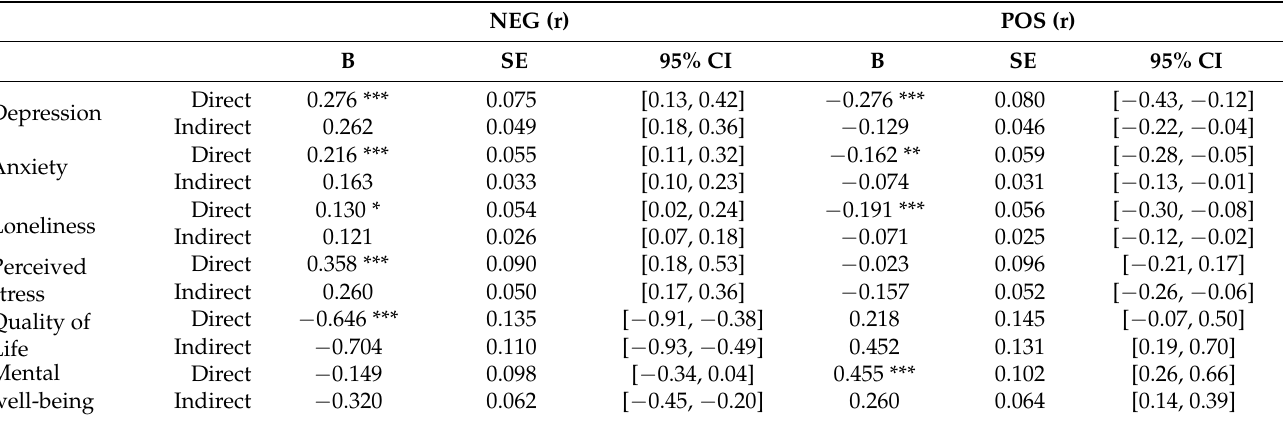
Table 8. Direct and indirect effects, via self-perceptions of aging, of the mediation